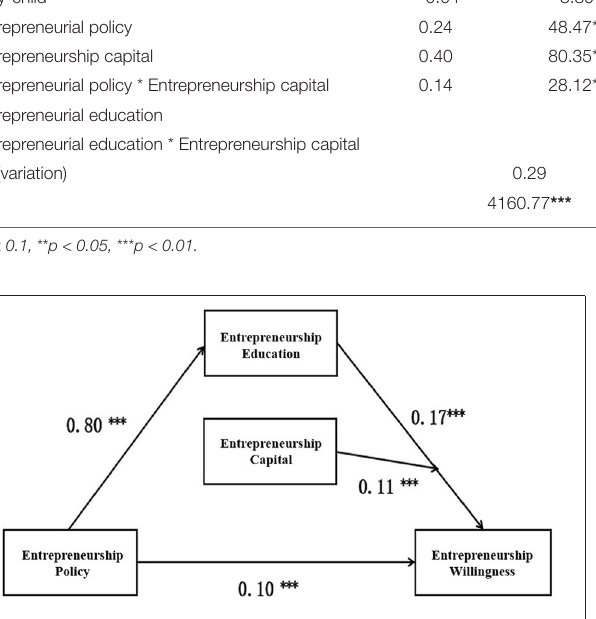
FIGURE 4 | The regulatory role of entrepreneurship capital in entrepreneurship education on entrepreneurial